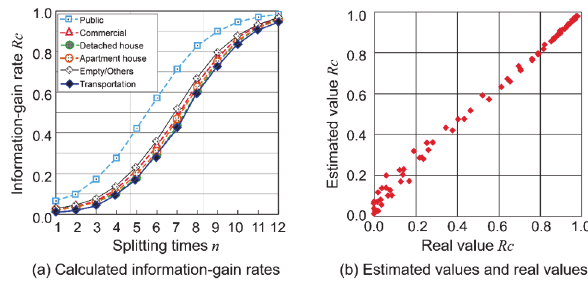
Figure 13 . Information-gain rate